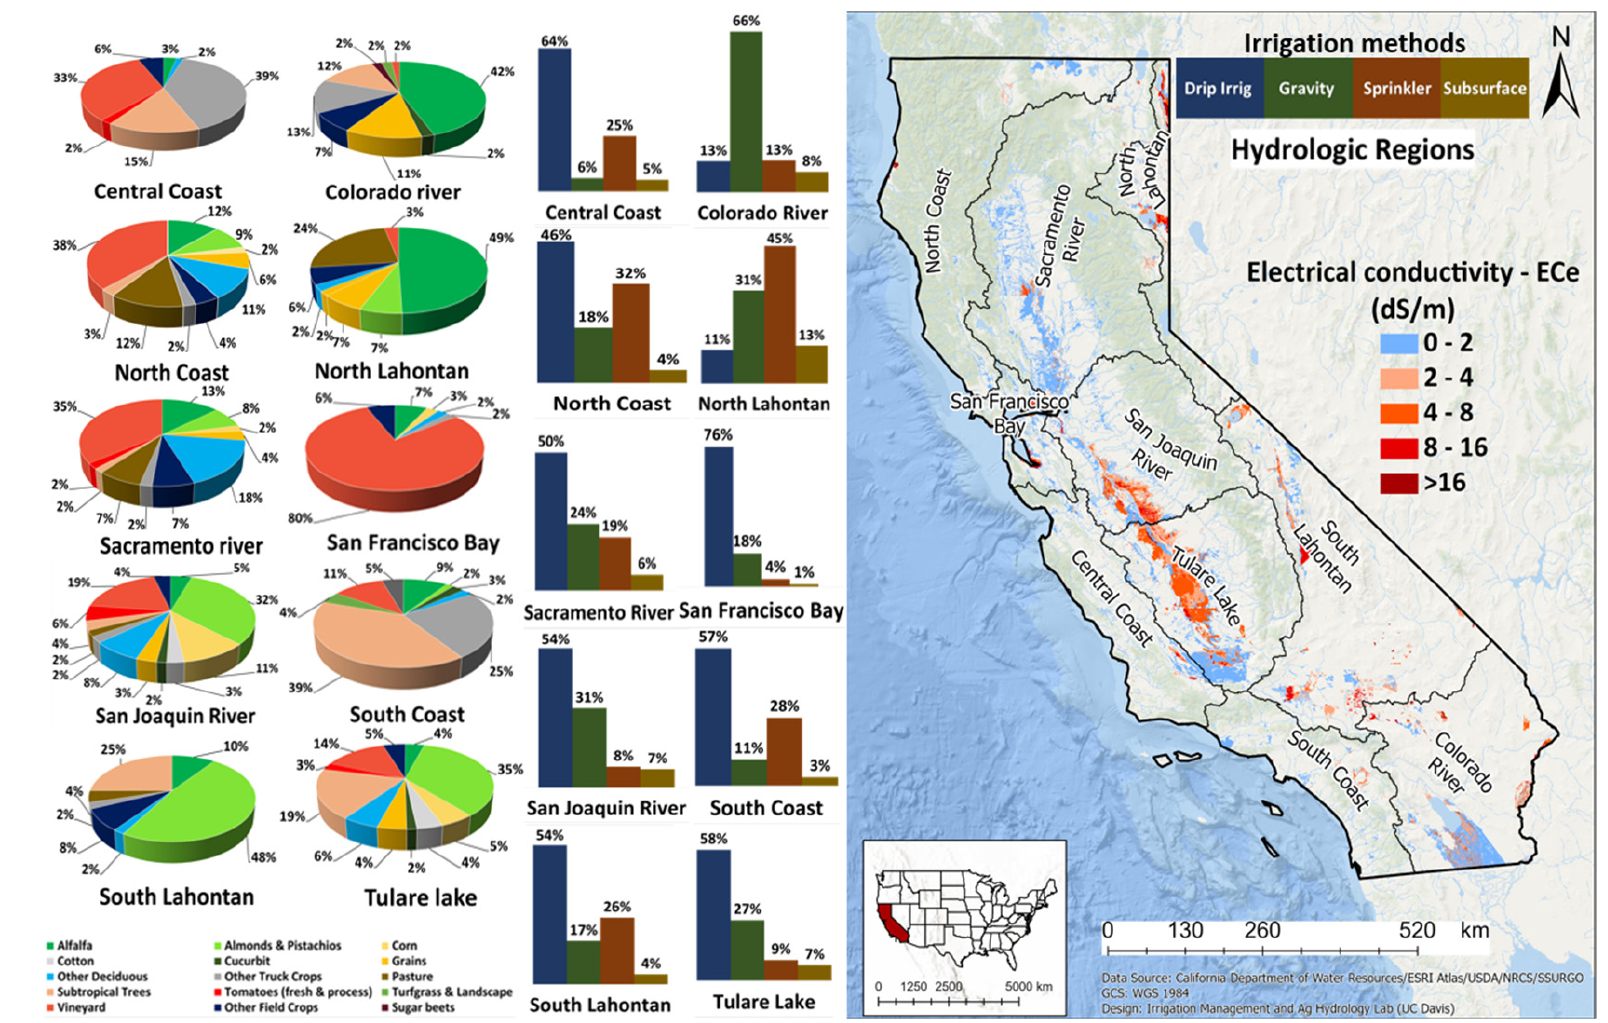
Figure 1. Distribution of irrigation methods, major crops and irrigation water salinity levels in hy- drologic regions of